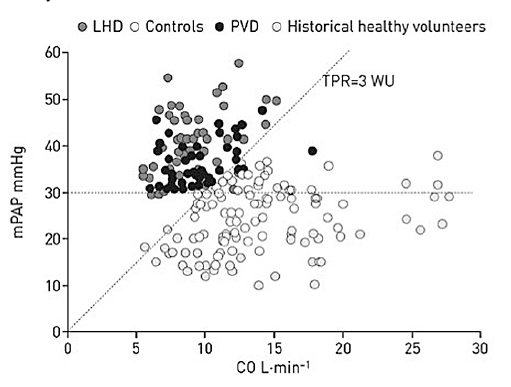
Figure 1: Relationship between exercise mean pulmonary arterial pressure (mPAP) and cardiac output (CO). Individual data points represent mPAP and CO reached at maximal exercise stratified by subjects with pulmonary vascular disease (PVD), left heart disease (LHD), control subjects and historical healthy volunteers. It can be seen that the total pulmonary resistance (TPR) line with a slope of 3 WU differentiated the diseased (PVD and LHD) and non-dis- eased groups (controls and historical volunteers). Reproduced from Hervé P [19] with permission of the European Respiratory Society.